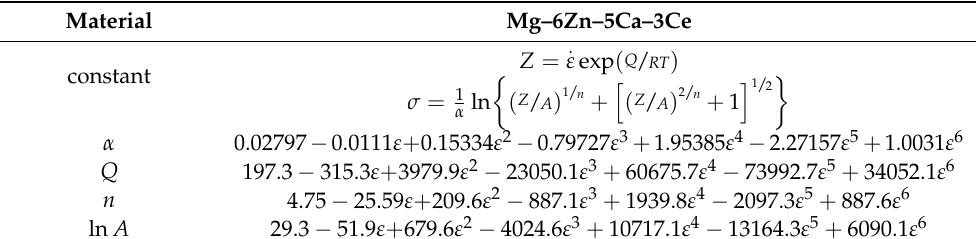
Table 4. The relationship between material constants and ε using sixth degree polynomial.